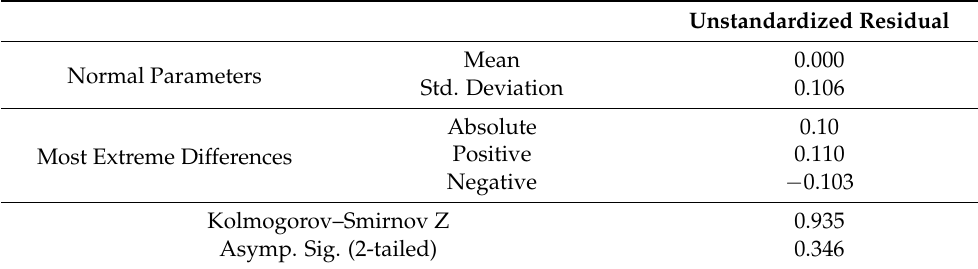
Table 3. One-Sample Kolmogorov–Smirnov Test before the COVID-19 Lockdown.